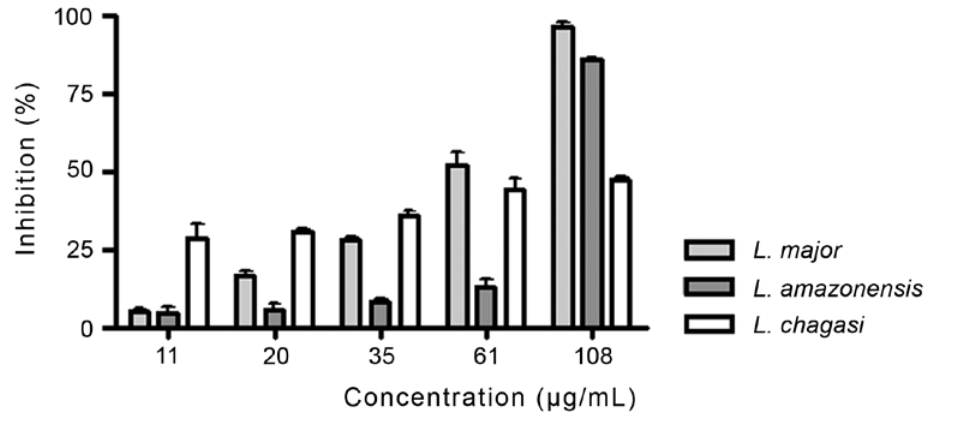
Figure 1 - Effect of the essential oil from M. frigidus on growth of L. major , L. amazonensis and L. chagasi promastigote forms. Parasites were treated with 11 to 108 µg/mL essential oil. Each bar represents the mean ± standard deviation of three different